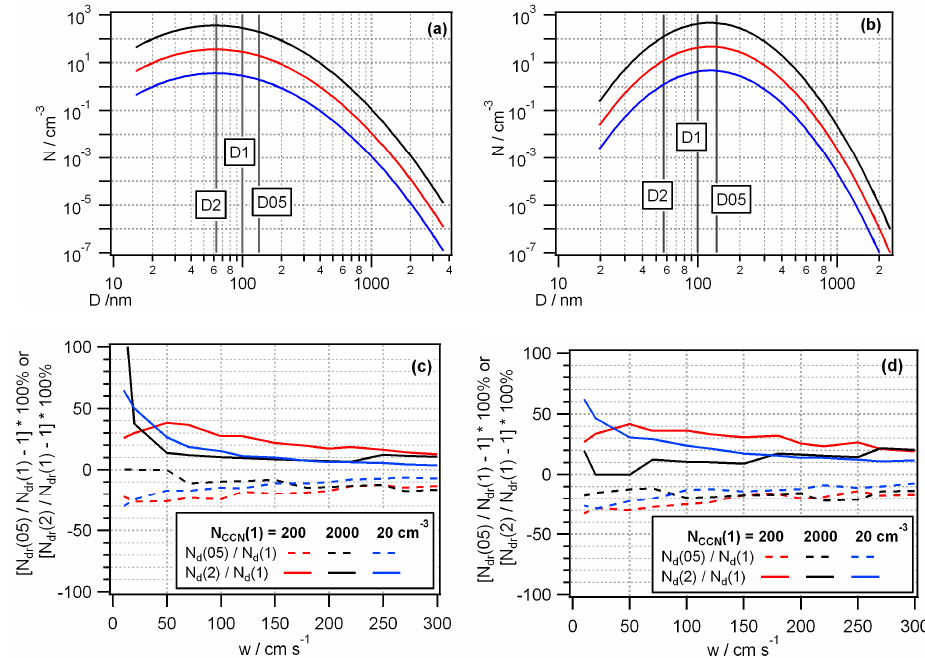
Fig. 4. (a) and (b) Example size distributions that are used as input data to the cloud parcel model. D1 denotes the critical diameter for particles that are activated at S = 0 . 3%, κ = 0 . 18 (“base case”). D 05 and D 2 denote the critical diameters for particles with a composition that result in 50% or 200%, respectively, of the activated number concentration as compared to the base case. (c) and (d) Relative difference between predicted drop number concentration for the compositions κ 05 and κ 2 to predicted drop number concentration using κ 1 as a function of updraft velocity in the cloud parcel